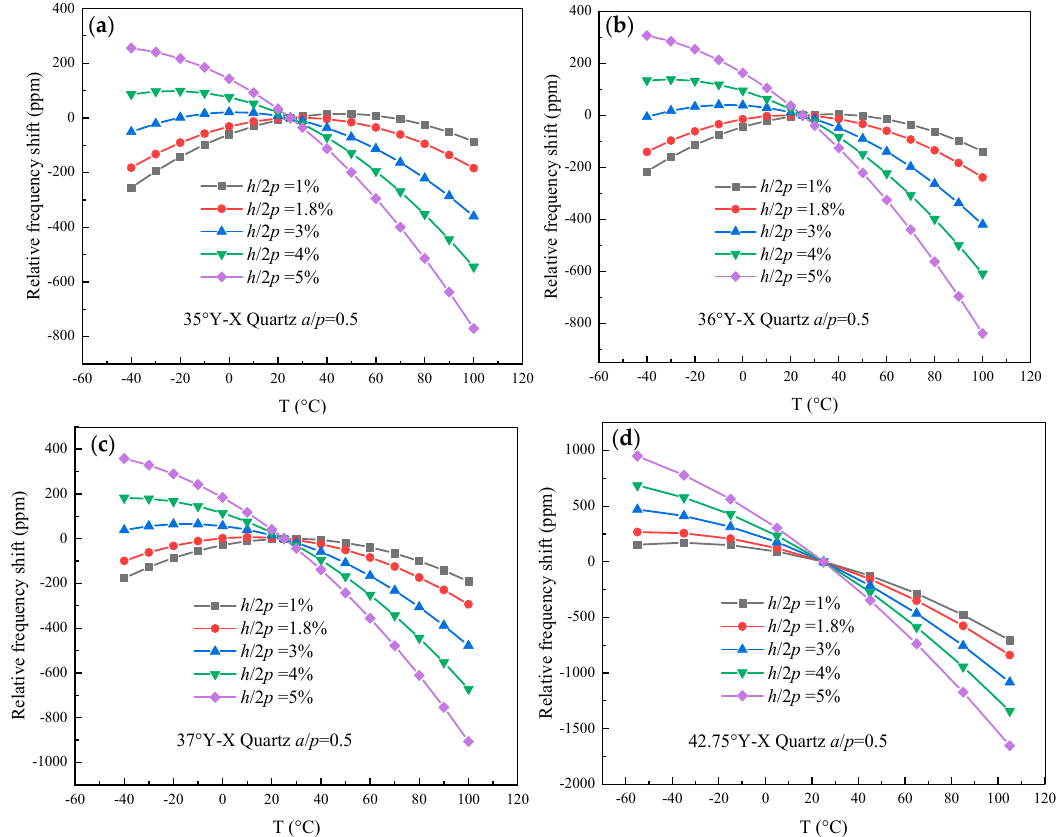
Figure 4. The relative frequency shift of quartz with different electrode thicknesses. ( a ) 35.0° Y-X quartz; ( b ) 36.0° Y-X quartz; ( c ) 37.0° Y-X quartz; ( d ) 42.75° Y-X quartz.